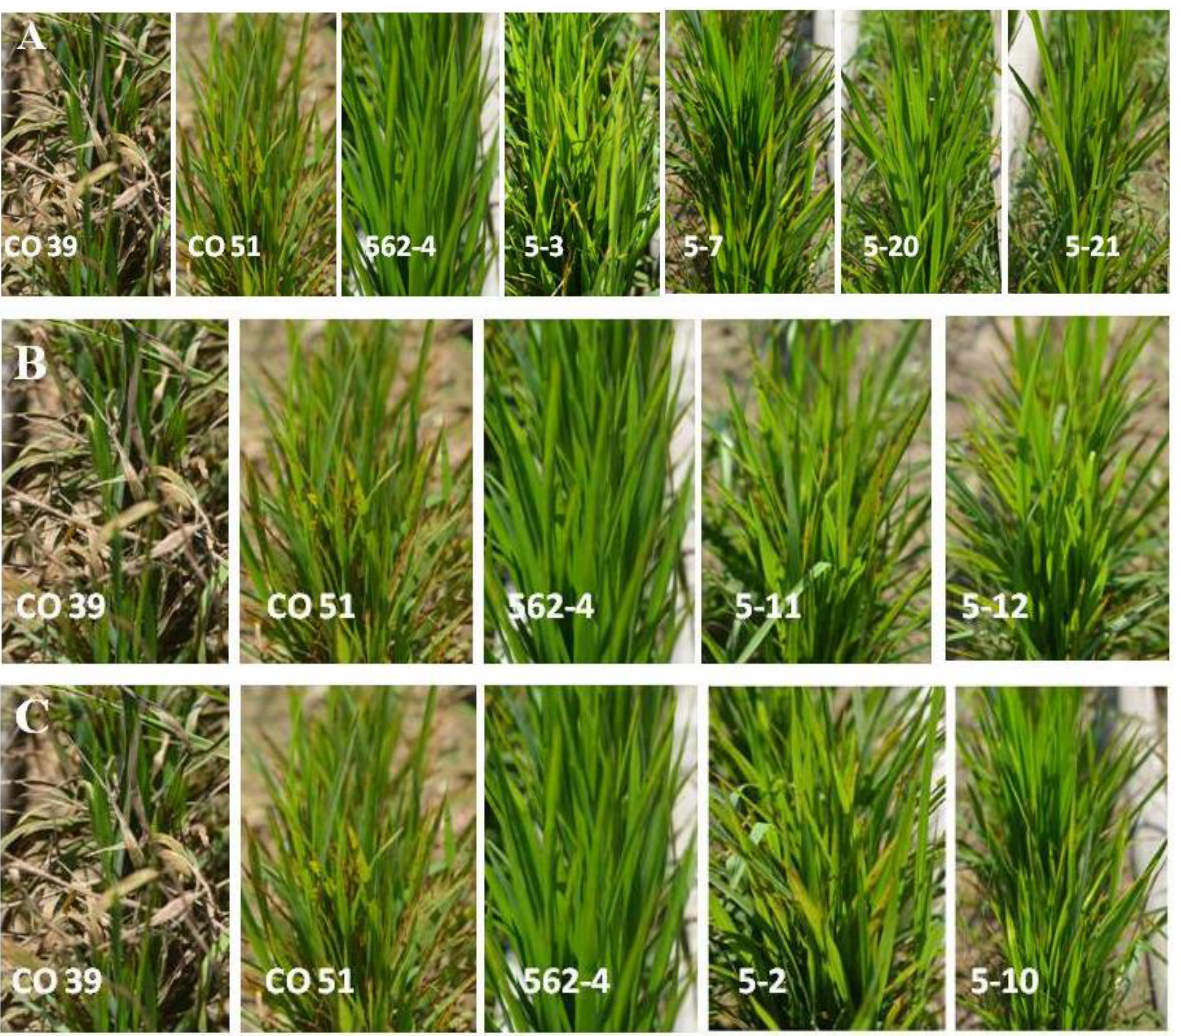
Figure 5. ( A ) Phenotypic responses of the susceptible check (CO 39), recurrent parent (CO 51), donor parent (562-4) and double genes ( Pi9 and Pi54 )-introgressed lines under uniform blast nursery ( B ) Phenotypic responses of the susceptible check (CO 39), recurrent parent (CO 51), donor parent (562- 4) and single gene ( Pi9 )-introgressed lines under uniform blast nursery ( C ) Phenotypic responses of the susceptible check (CO 39), recurrent parent (CO 51), donor parent (562-4) and single gene ( Pi54 )- introgressed lines under uniform blast